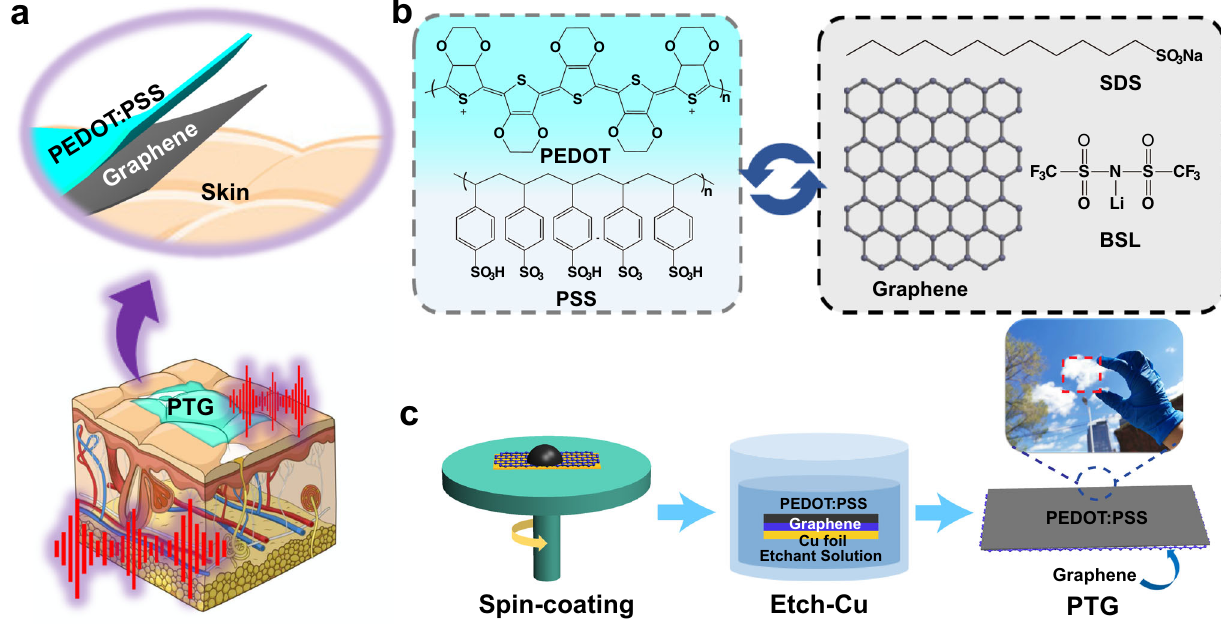
Fig. 1 Fabrication of PTG as a skin electrode. a Schematic illustration of PTG as a skin electrode for electrophysiology. b Chemical structure of PEDOT:PSS, graphene, SDS, and BSL. c Schematic illustration of the fabrication process of the double-layer stacked structure of PEDOT:PSS/graphene. Inset is a transparent PTG held on a plastic